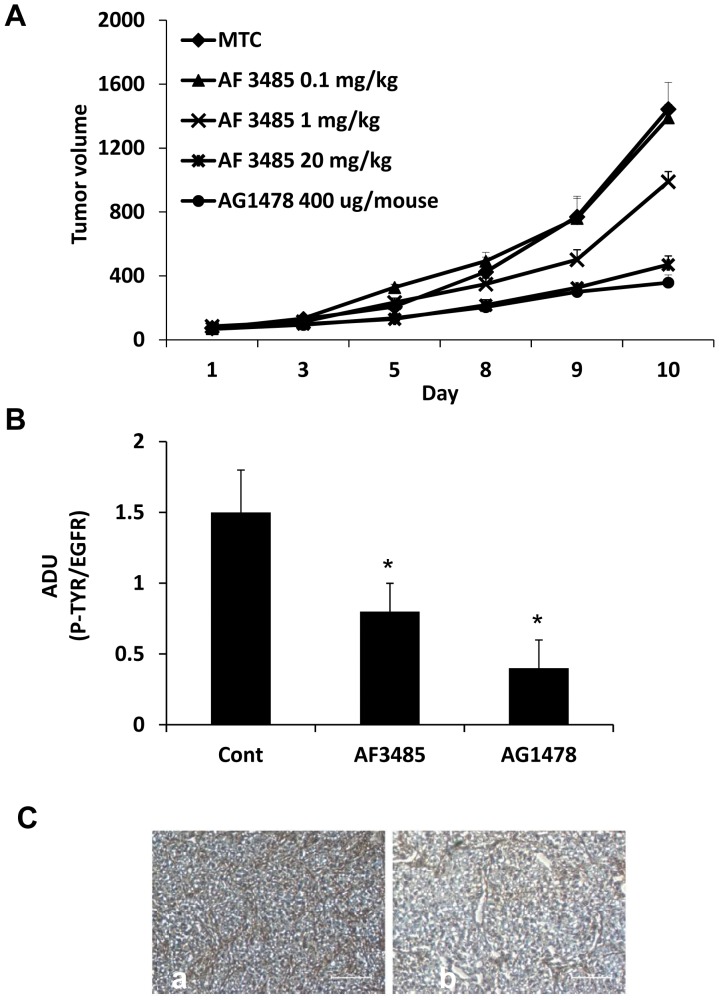
The mPGES-1 inhibitor AF3485 reduces A431 tumor growth in xenograft nude mice.(A) Tumor volume measured in athymic mice inoculated with A431 cells and treated with vehicle (Ctr, 0.5% MTC), AF3485 (20, 1, or 0.1 mg/kg/mouse), or AG1478 (400 µg/mouse). (B) EGFR phosphorylation in xenograft tumor tissues reported as optical density (OD  =  ratio between phospho-tyr and EGFR expression). *P<0.05 vs Cont. (C) Representative images of the proliferative Ki67 index in tumor sections.